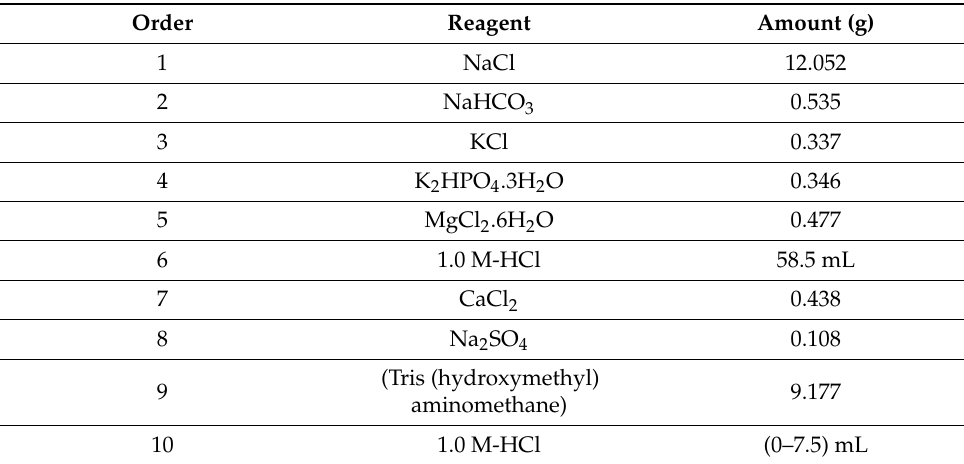
Table 1. The order of chemicals for SBF